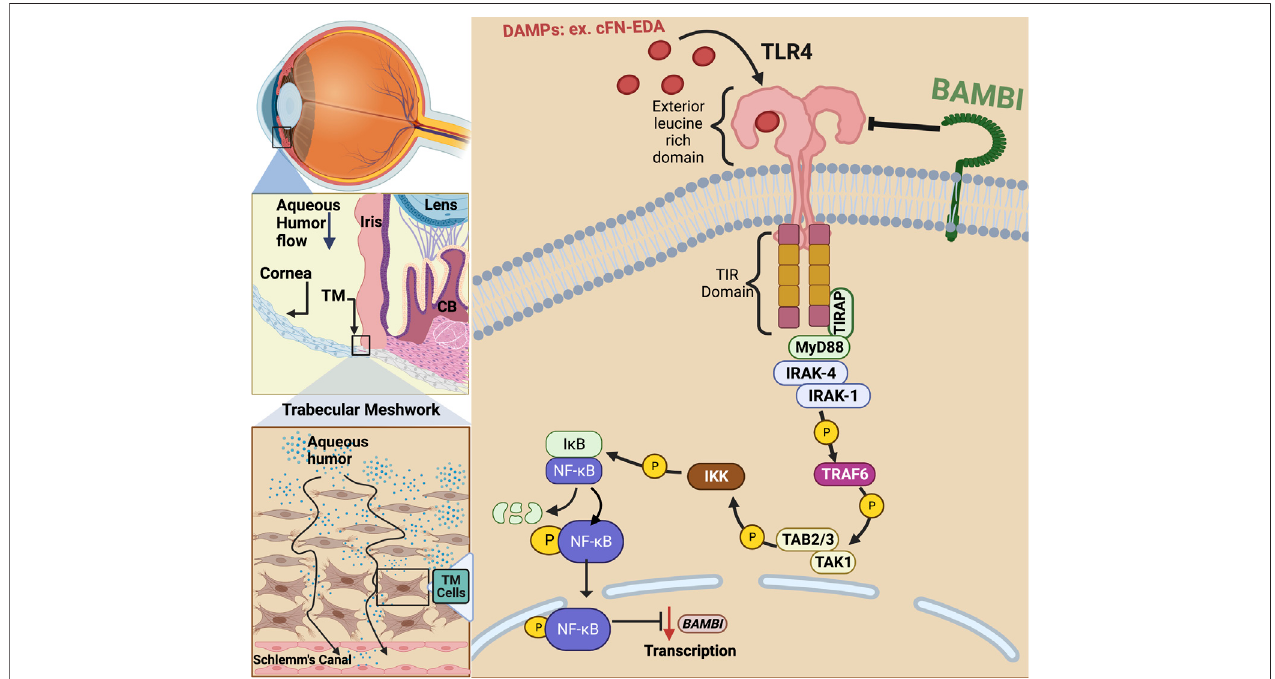
FIGURE 1 | TLR4 activation in the trabecular meshwork. In primary open-angle glaucoma, damage to the TM and inner wall of Schlemm ’ s canal (SC) endothelium preventssuf fi cient aqueoushumorout fl owleadingtoelevated IOP. Damage associatedmolecular patterns (DAMPs) suchascellular fi bronectincontainingEDA isoform (cFN-EDA) are produced from TM tissue damage and excess TGF β 2 signaling and can activate TLR4 leading to Nuclear Factor-Kappa Beta (NF- κ B) activation and downregulation of BMP and Activin Membrane Bound Inhibitor (BAMBI) expression.